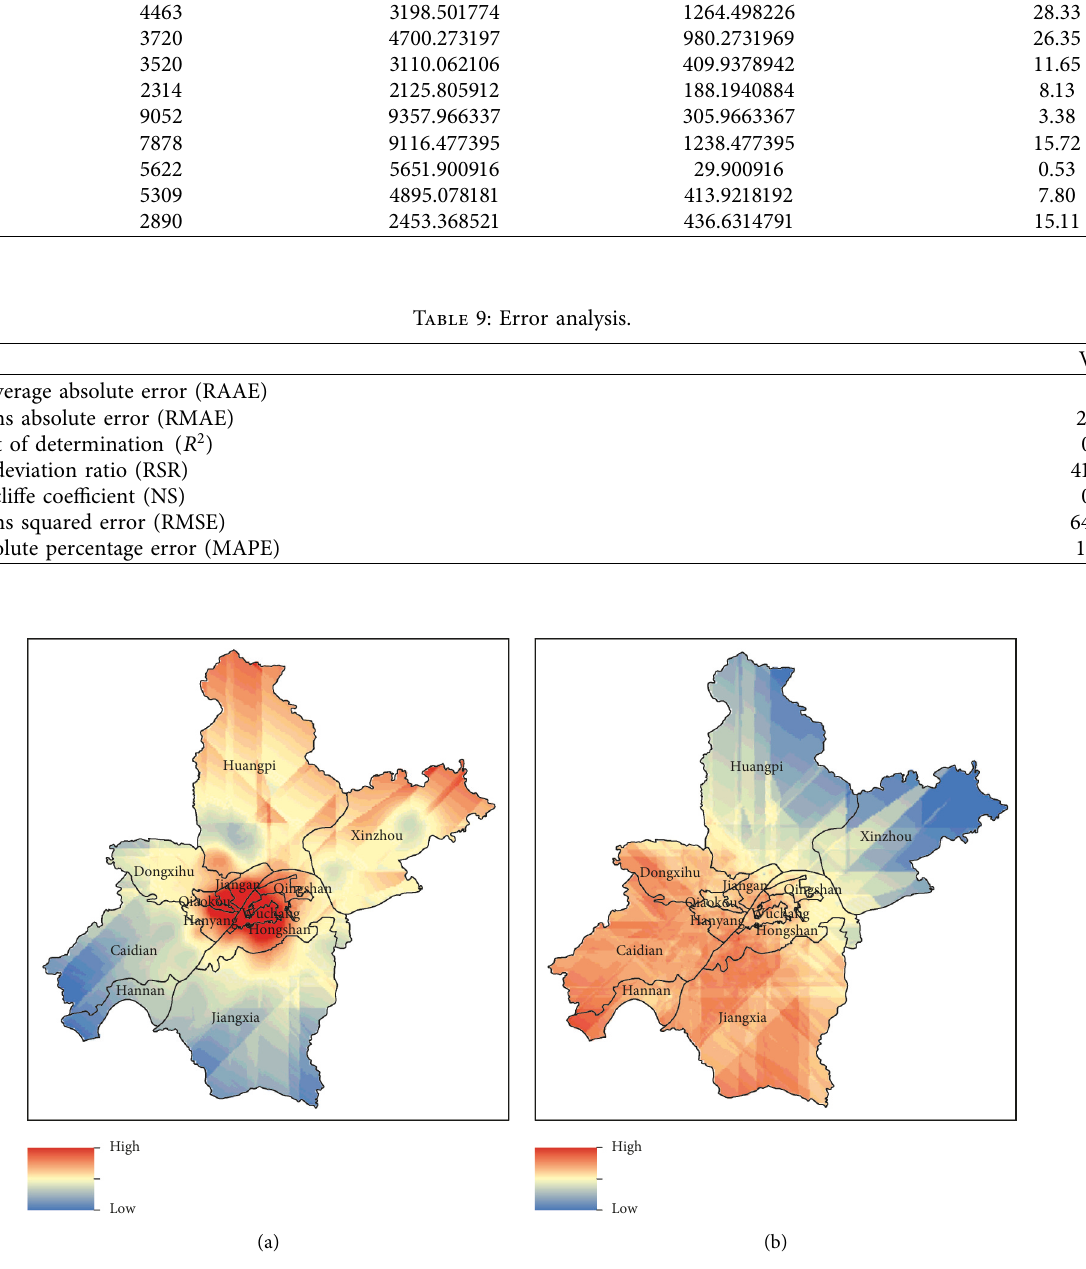
Figure 6: Actual land price and relative error heat map: (a) actual land price and (b) relative